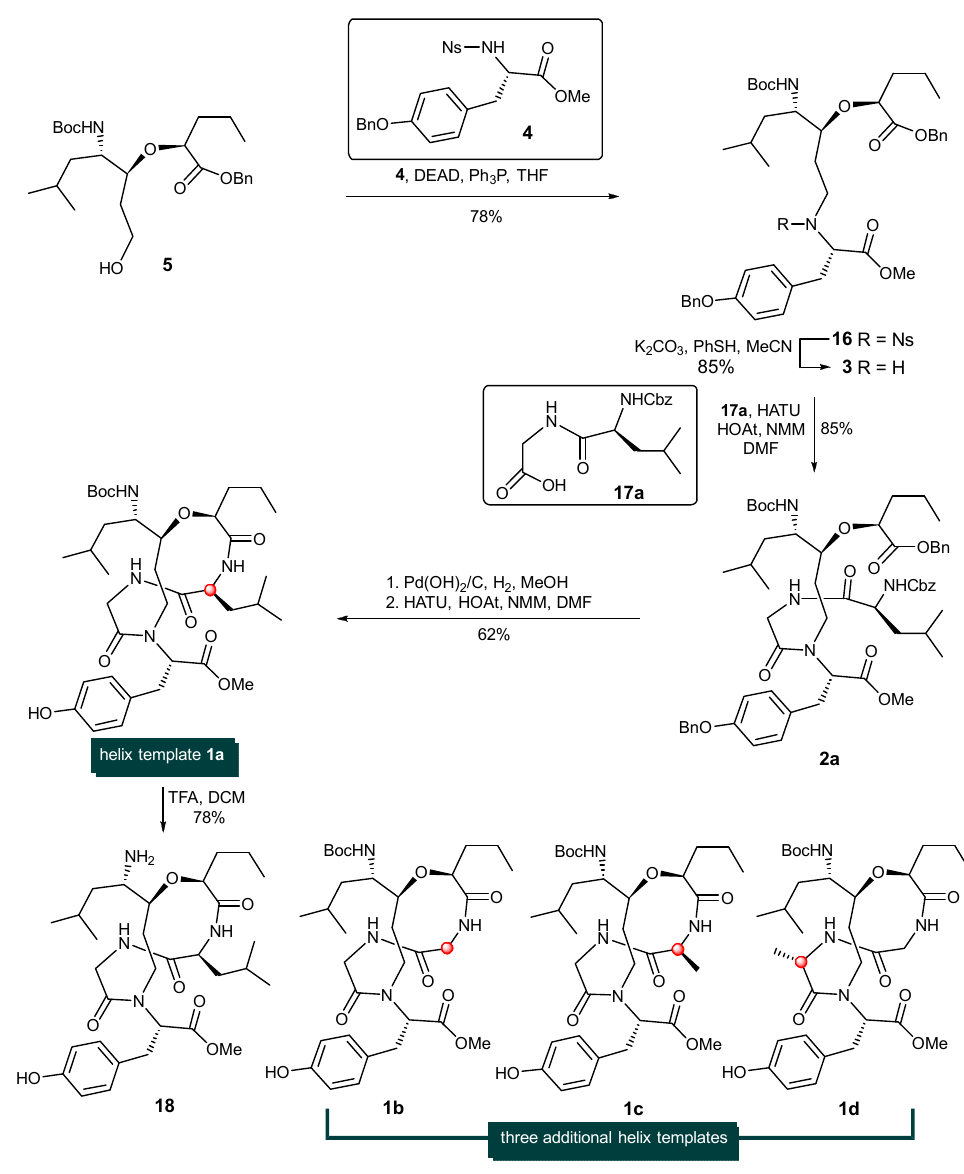
Figure 1. CD spectra of compounds 1 and 18 . (( Left ) panel: 1a (blue), 1b (red), 1c (black), and 1d (green), all were recorded in 10 mM sodium phosphate buffer (pH 7.4); ( Right ) panel: 18 in 10 mM phosphate buffer pH 7.4 (black) and in 50% TFE (blue)).